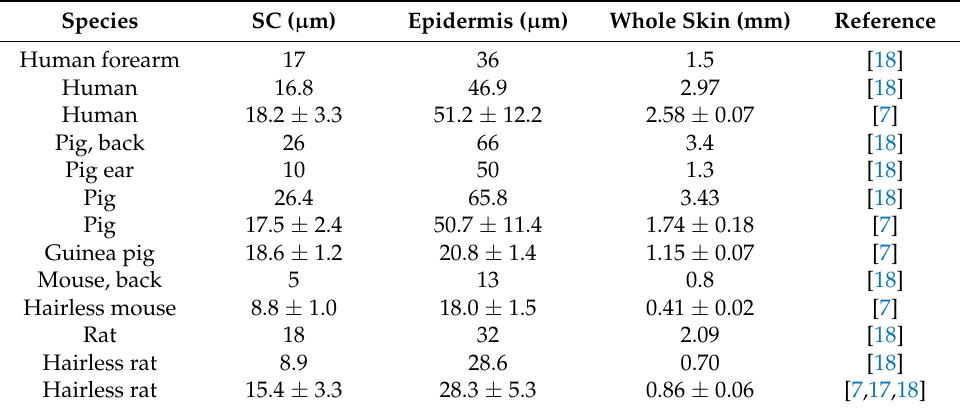
Table 1. Comparison of skin thickness among species and anatomical